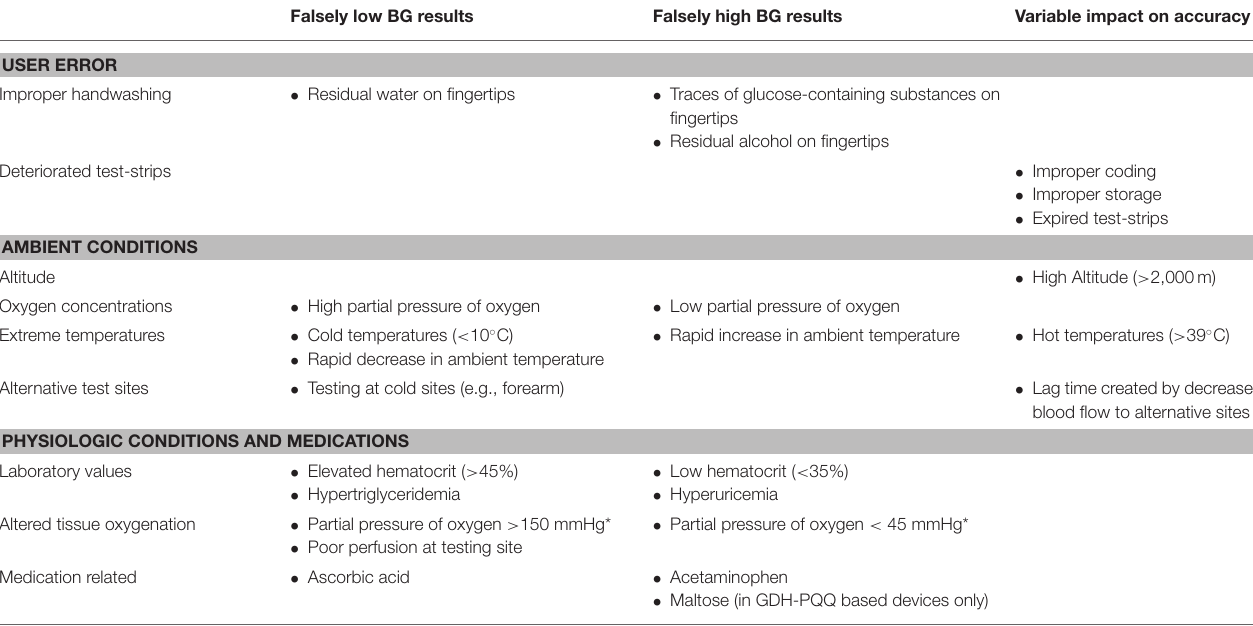
TABLE 3 | Factors impacting the accuracy of self-monitored blood